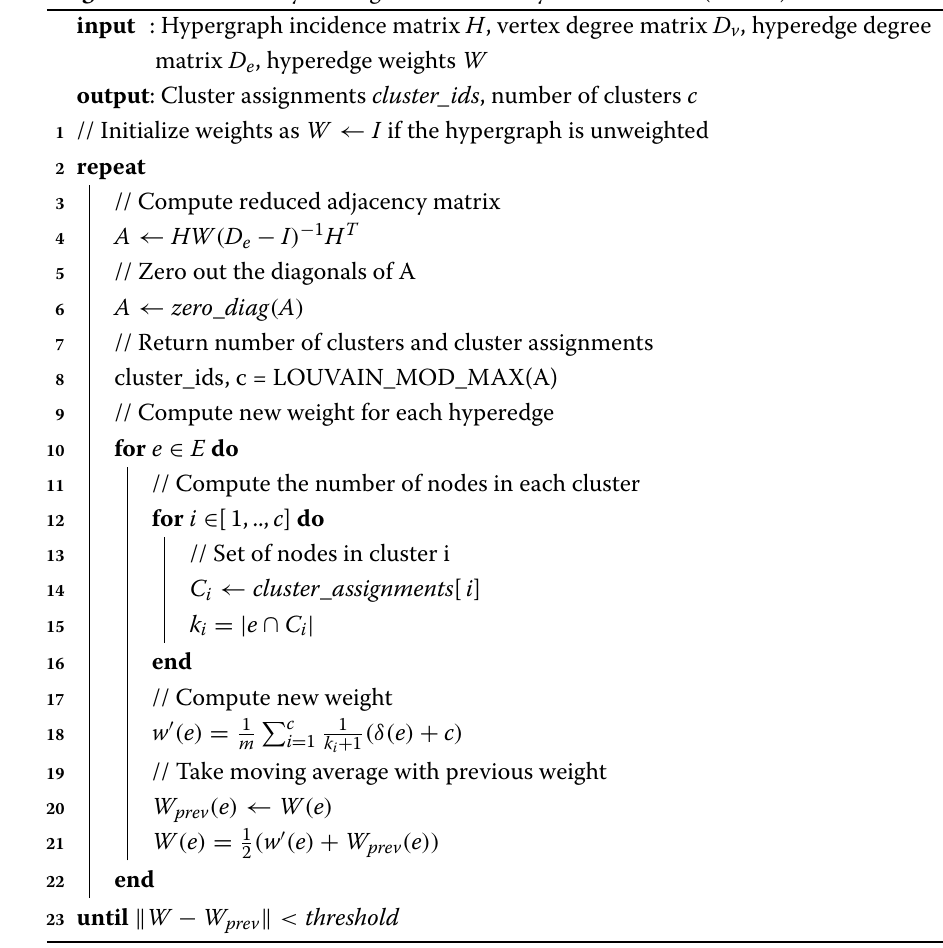
Algorithm 1: Iteratively Reweighted Modularity Maximization